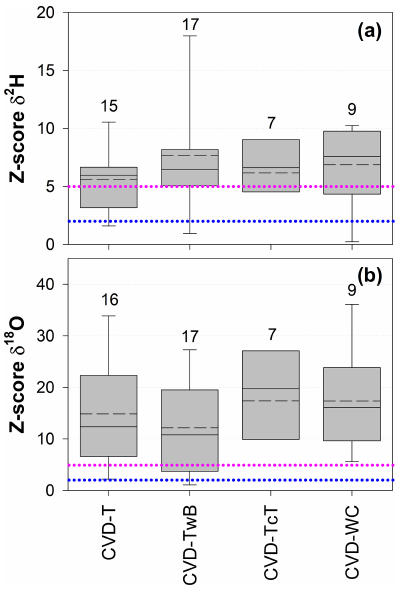
Figure 8. Dimensionless Z score values for δ 2 H (a) and δ 18 O (b) grouped by sample types (CVD: cryogenic vacuum distillation; T: twig without bark; TwB: twig with bark; TcT: twig close to the trunk; WC: wood core). Samples from the four species were grouped together and numbers above the boxes represent the sample size. The boxes indicate the 25th and 75th percentile, the whiskers indicate the 10th and 90th percentile, whereas the horizontal solid and dashed lines within the box mark the median and the mean, re- spectively. The dotted blue and pink lines represent the upper limits for acceptable ( Z score = 2) and questionable ( Z score = 5) differ- ences, respectively, between the SPC (i.e., Scholander-type pressure chamber) and the CVD-extracted